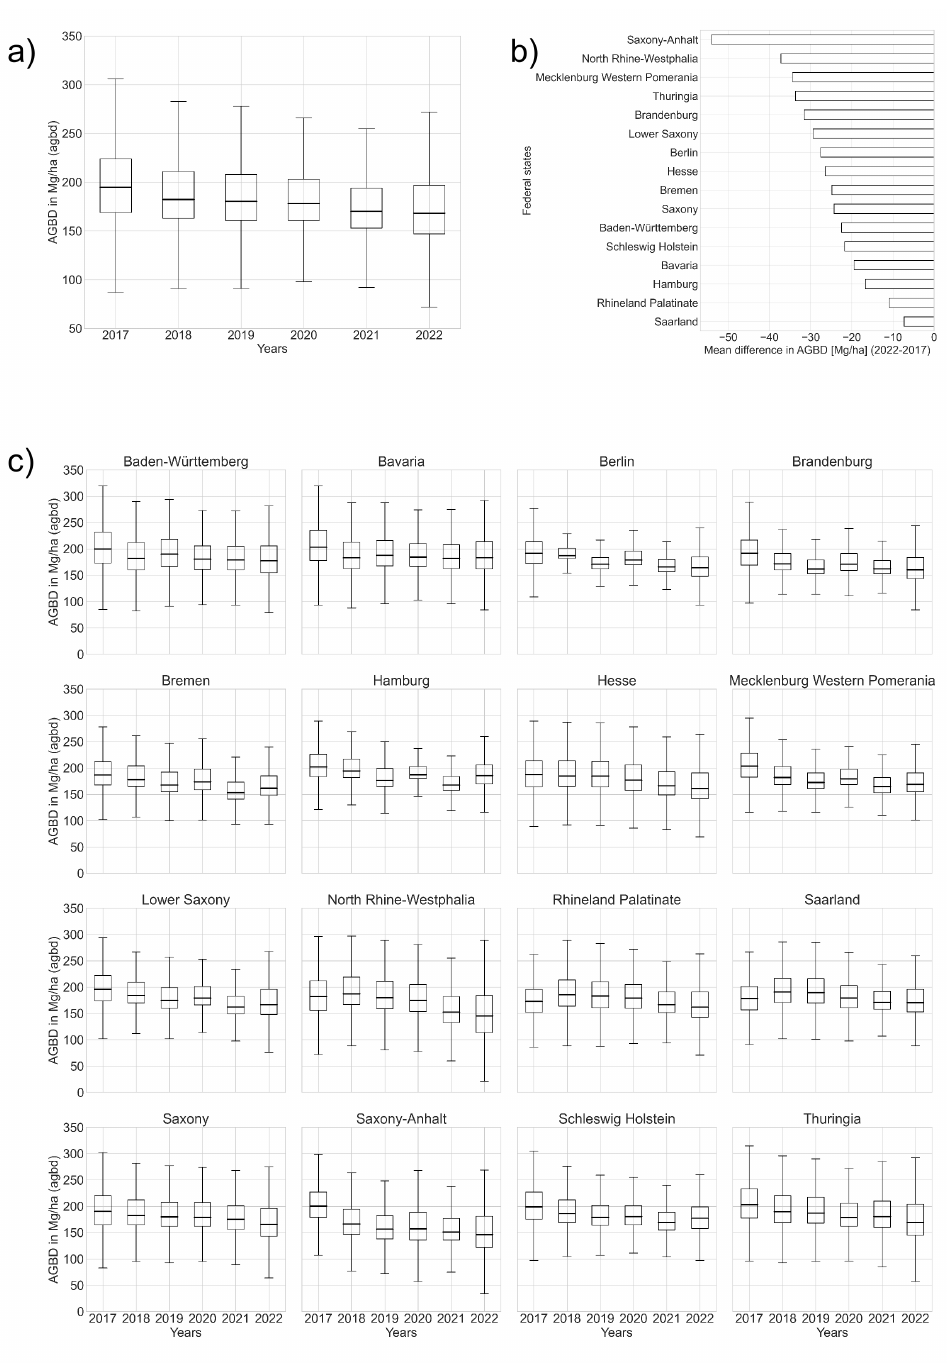
Figure A2. Quantitative statisticsof AGBD in forested areas of Germany: Overall dynamics in AGBD in Germany ( a ), mean difference in AGBD (2022–2017) among federal states ( b ), multi-temporal change in AGBD grouped by federal states ( c ). The statistics are based on predicted pixel estimates depicting mean values as horizontal line in the boxplots. General dynamics of forest structure are assessed; absolute values should be interpreted in the context of model